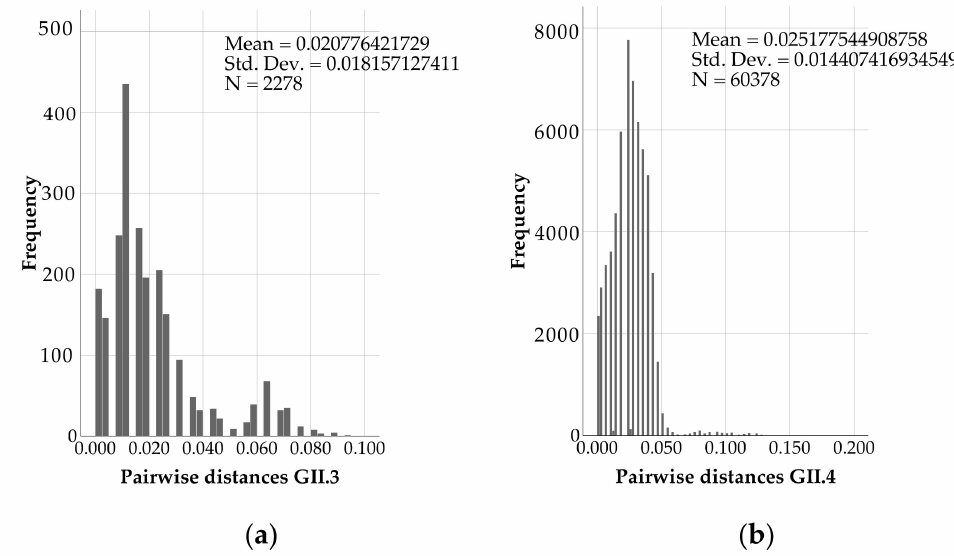
Figure 5. Pairwise distances within norovirus ( a ) GII.3 and ( b ) GII.4 sequences calculated by Jukes Cantor method in